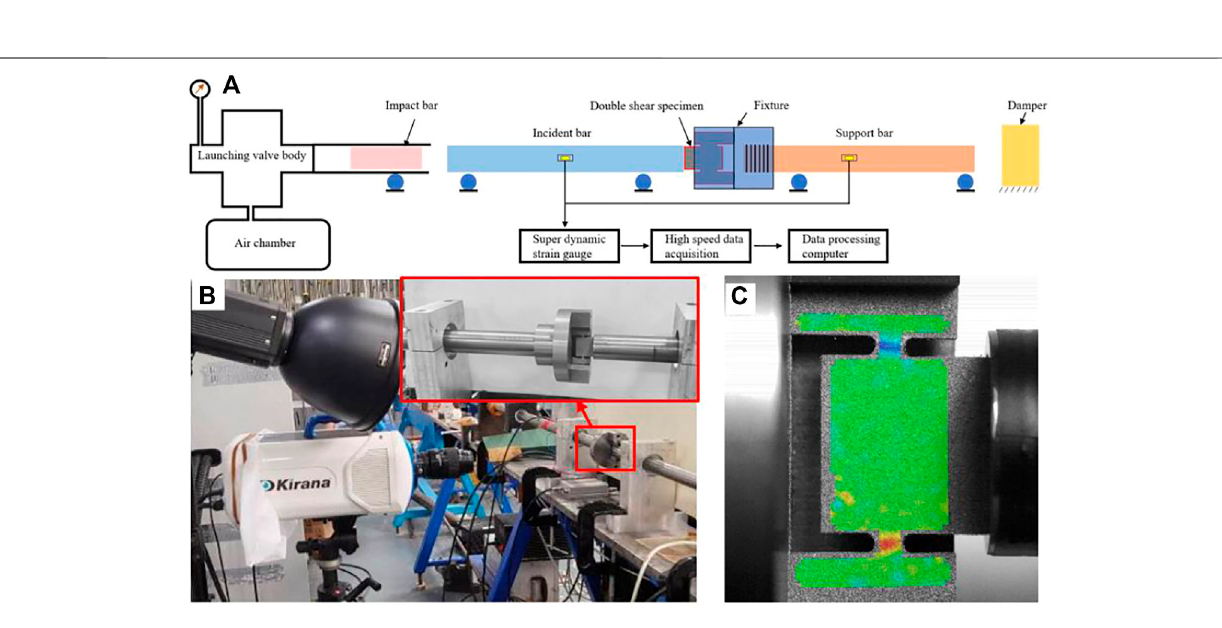
Frontiers in Energy Research |